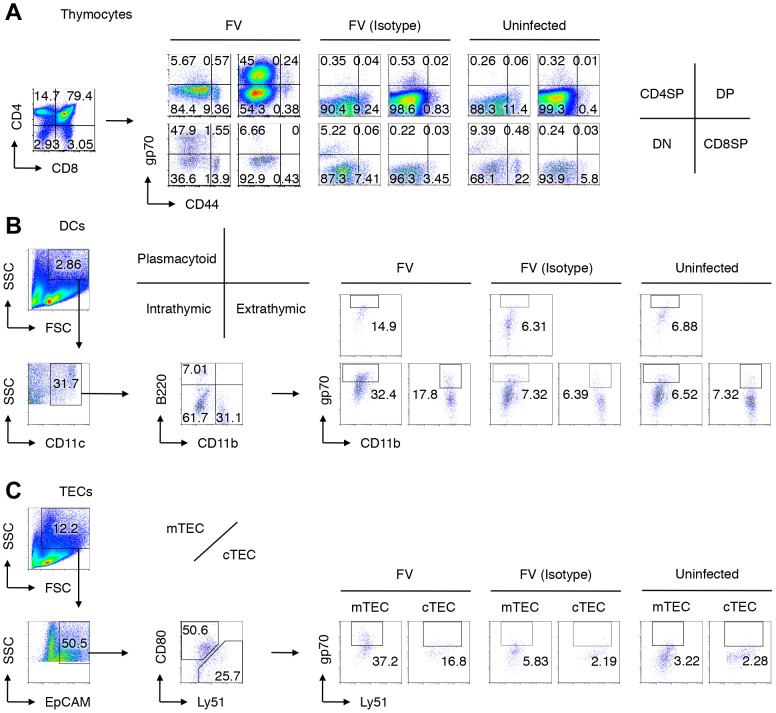
Viral antigen expression in each cell population in the thymus after FV infection.Mice were infected with 1,000 SFFU of FV. At day 14 after infection, cells in the thymus were isolated and stained with indicated Abs. Shown are representative staining patterns and gating protocols of thymocytes (A), thymic DCs (B), and TEC populations (C). (B) Cells purified from the thymus were incubated with microbeads-labeled anti-CD90.2 antibody, and antibody-negative populations were further stained with fluorescent-labeled anti-CD11b, anti-CD11c, anti-B220, and anti-gp70. CD11c+ cells were separated into B220+ plasmacytoid DCs, B220−CD11b− DCs of intrathymic origin, and CD11b+ DCs of extrathymic origin. (C) CD90.2− populations were stained with fluorescent-labeled anti-EpCAM, anti-CD80, anti-Ly51, and anti-gp70. EpCAM+ cells were separated into CD80+ medullary TECs (mTECs), and Ly51+ cortical TECs (cTECs). Nonspecific binding of the biotinylated anti-gp70 mAb 720 especially onto DN thymocytes, DCs and TECs was inevitable even in the presence of anti-Fc receptor Abs, as evidenced by the background staining with the isotype control IgG. Thus, the percentages of “gp70+” cells shown here include some background values.